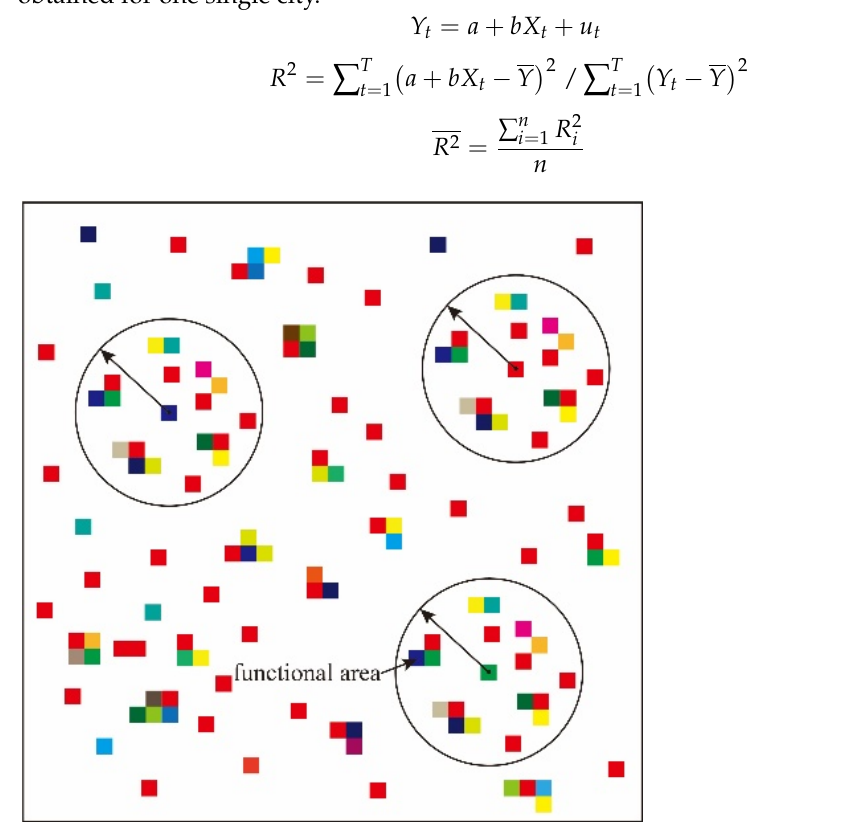
Figure 2. The buffer for statistic the spatial distribution of functional areas. (The different colored squares represent different types of functional areas) squares represent different types of functional